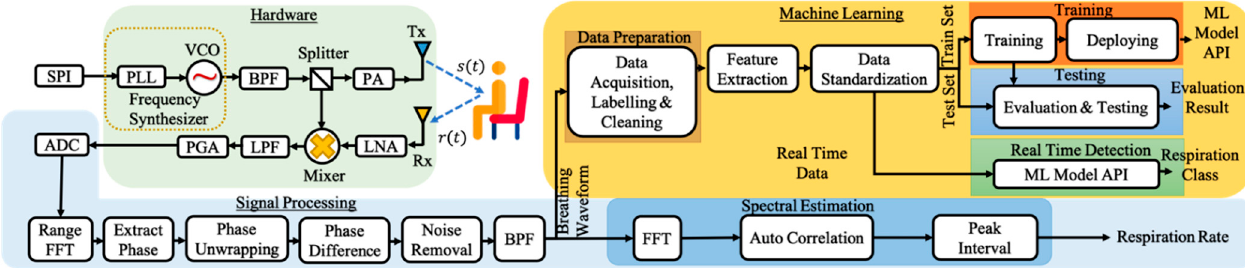
Figure 2. Block diagram of the proposed system.